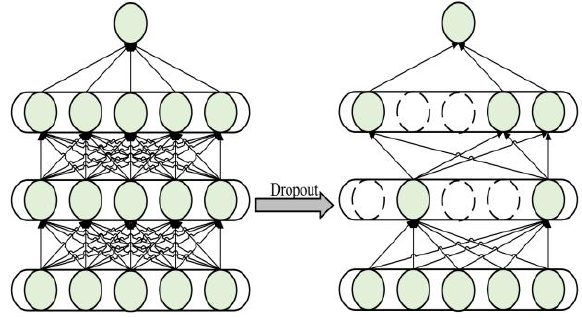
Fig. 2. Schematic diagram of Dropout layer